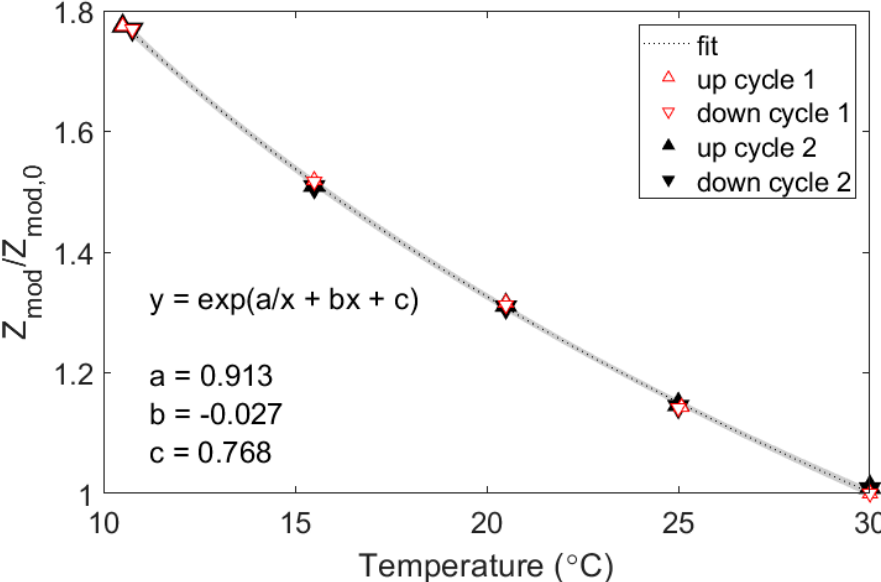
Figure 10. Normalized impedance response of metakaolin 3D printed AAM patch to temperature during four temperature cycles. Z mod is the modulus impedance at a given temperature and Z mod,0 the initial modulus impedance at 10 °C [27].